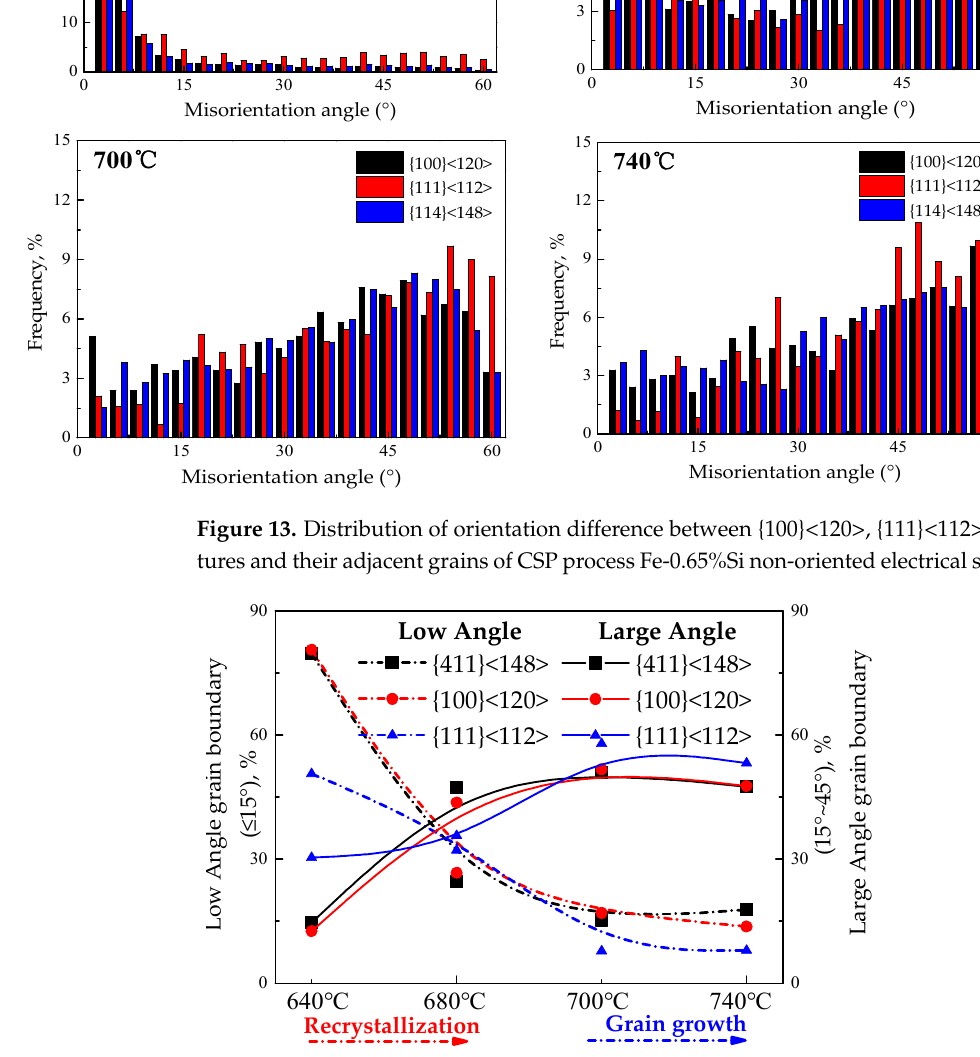
Figure 14. Angle distribution of grain boundaries between specific orientation grains and adjacent grains of CSP process Fe-0.65%Si non-oriented electrical steel annealed sheets, %. Annealing at 640 °C, {111}<112> oriented grains with low-angle grain boundaries be- The average grain size has increased to 11.4 µ m in the 740 ◦ C annealing sheet, and tween adjacent grains (orientation difference with adjacent grains less than 15°) account that of {411}<148> and {100}<120> oriented grains are 12.9 and 12.1 µ m, respectively, which for 50.64%, the ratio of low-angle grain boundaries between oriented grains and adjacent are smaller than {111}<112> oriented grains (the average grain size is 14.5 µ m). After grains of {411}<148> and {100}<120> are 79.66% and 80.6%, respectively. {411}<148> and annealing at 740 ◦ C, the proportion of low-angle grain boundaries of {111}<112> is 7.95%, {100}<120> oriented grains account for 14.65% and 12.6% of high mobility grain bounda- and low-angle grain boundaries of {411}<148> and {100}<120> are 17.8% and 13.71%, ries (the difference in orientation with adjacent grains is greater than 15° and less than 45° respectively. Compared with the recrystallization process, the low-angle grain boundaries grain boundaries), respectively; {111}<112> oriented grains accounted for 30.37% of high have decreased, but the low-angle grain boundaries of {411}<148> and {100}<120> are mobility grain boundaries. Therefore, in the early stage of recrystallization, {111}<112> higher than that of {111}<112>. The proportions of high mobility grain boundaries of {411}<148>, {100}<120> and {111}<112> are 47.5%, 47.67% and 53.2%, texture precedes {411}<148> and {100}<120> textures to recrystallize. With the progress of recrystallization, the ratio of {411}<148> and {100}<120> recrystallization texture is greater